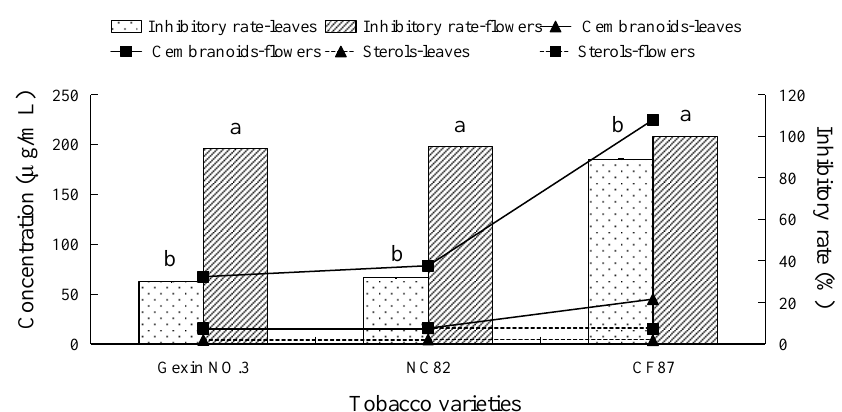
Figure 3. Inhibitory rate against V. mali and the concentration of terpenes in tobacco flower and leaf n -hexane extracts. Columns with different letters represent organs with significantly different values according to Duncan’s multiple range tests at p < 0.05.